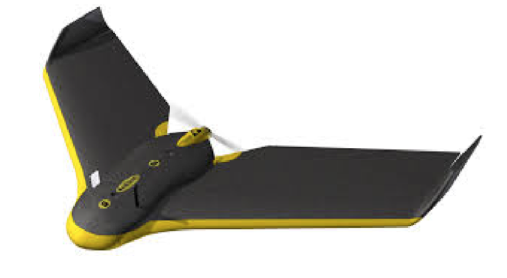
Figure 3. UAV platform used in this